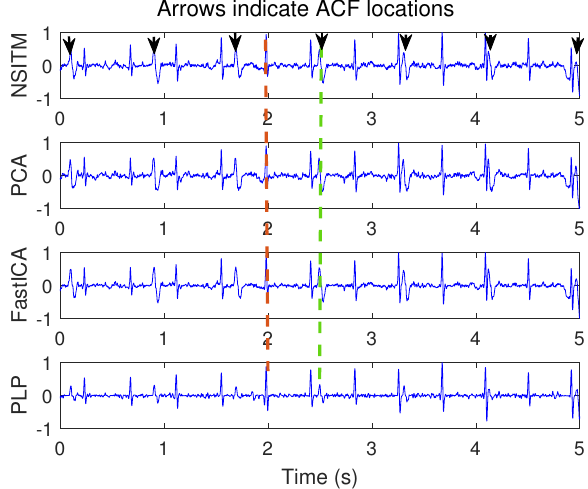
Figure 10. Raw FECG signals from ECG signals in Figure 9, using NSITM, PCA, FastICA, and PLP, assuming M = 4. Both FECG and MECG R peaks exist. For illustration, only one marked FECG peak and one marked MECG peak are shown by red dashed lines (left located) and green dashed lines (right located), respectively. The black arrows indicate the position of the ACF used to remove the MECG R peaks.The y -axis labels refer to the names of the algorithms used for extracting the FECG signals. The data used are from the Physionet Challenge 2013 data set a, file